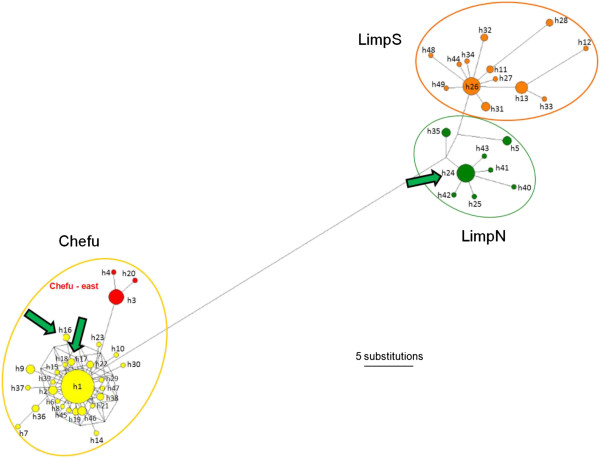
Median-joining network of 149 sequences of 687 bp of CYTB from 36 populations. Length of branches is proportional to the number of substitutions along a given branch, and circle size is proportional to haplotype frequency. Haplotypes from three main genetic groups (LimpS, LimpN, Chefu) are enclosed by circles of different colours. Private haplotypes from the easternmost localities in the Chefu basin (Pop225 and Pop423) are in red. Green arrows indicate haplotypes co-occurring in Pop406 (haplotypes h16, h17, and h24).